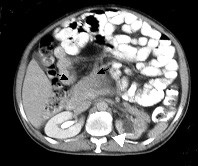
Abdominal CT image shows homogenous, well-defined, mass lesion in the retroepritoneal area (black arrows). Grade 3 hydronephrosis in the left kidney is shown with white arrowhead.